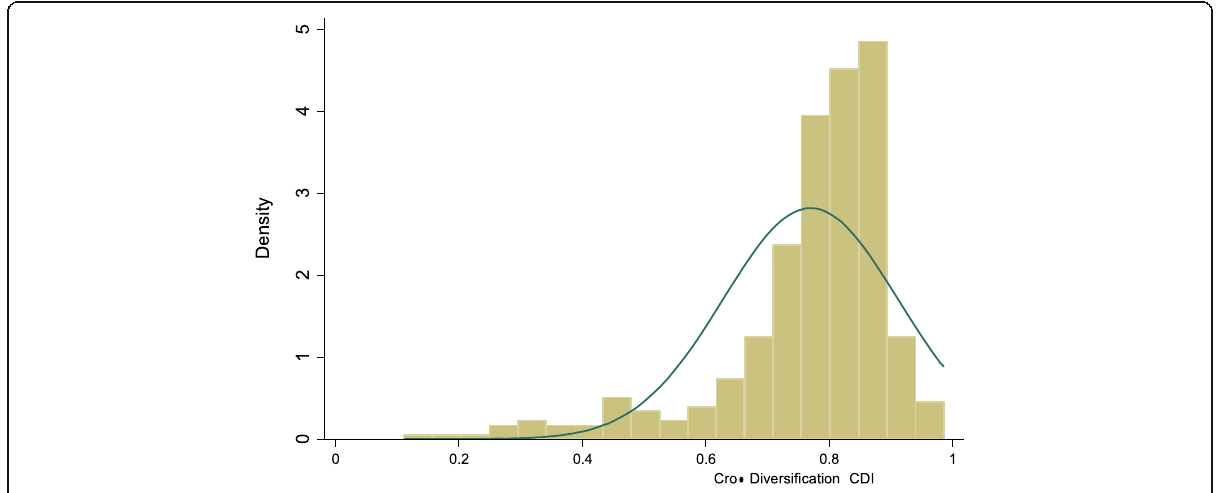
Fig. 3 Mean of household ’ s crop diversification index